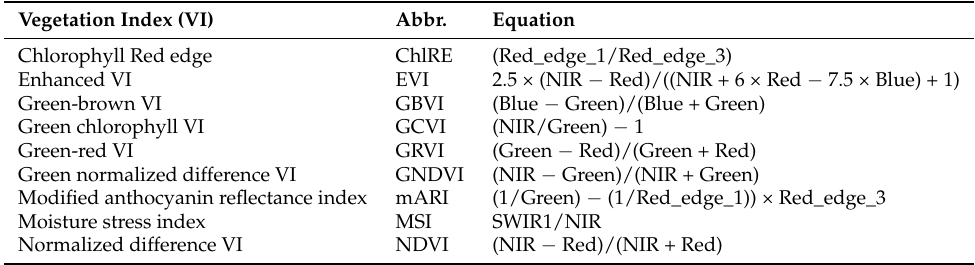
Table 2. Vegetation indices (VIs) used, their abbreviation (Abbr.), and the equation used to compute them with Sentinel-2 bands: Blue (band 2) = 494 nm, Green (band 3) = 560 nm, red (band 4) = 665, Red edge (band 5) = 704 nm, Red edge 2 (band 6) = 740 nm, Red_edge_3 (band 7) = 780 nm, NIR (band 8) = 834 nm, Red edge 4 (band 8A) = 864 nm, SWIR 1 (band 11) = 1612 nm, SWIR2 (band 12) = 2194